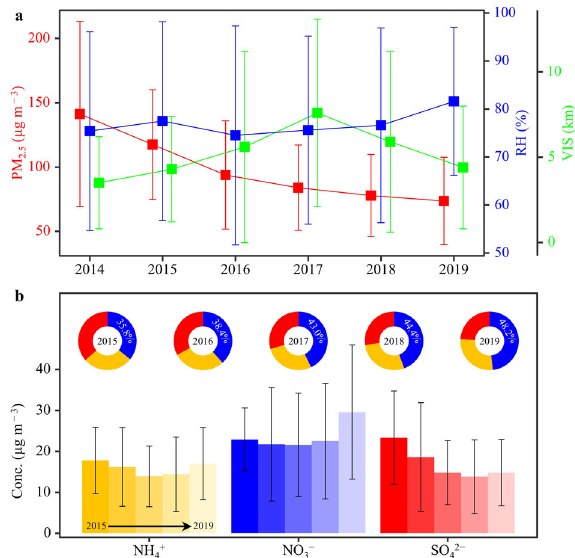
Fig. 7 Unsatisfactory visibility improvement along with steady increases in nitrate fractions. a Interannual trends in PM 2.5 concentration, relative humidity (RH), and ambient visibility (VIS) in Wuhan during 2014 – 2019 wintertime (January and February). b Interannual trends in NH 4 + , NO 3 − , and SO 42 − concentrations and their contributions to SNA for PM 2.5 during 2015 – 2019 wintertime (January and February). The error bar represents one standard